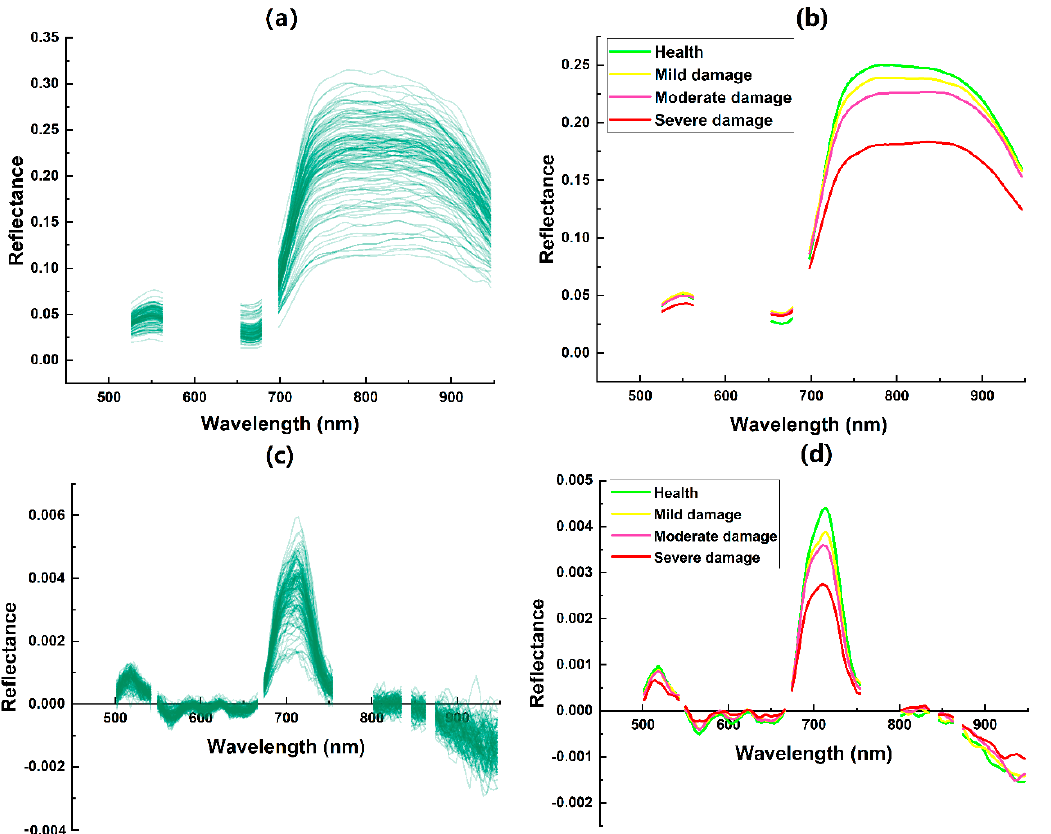
Figure S4. Sensitive bands of spectral reflectance and the first derivative with the damage degrees by Tomicus in Pinus yunnanensis canopy (( a ) Spectral reflectance of 120 samples; ( b ) Mean spectral reflectance; ( c ) Spectral first derivative curves of 120 samples; ( d ) Mean spectral first derivative). Table S1. Extraction of sensitive bands for spectral reflectance and the first derivative of Pinus yun- nanensis canopy.